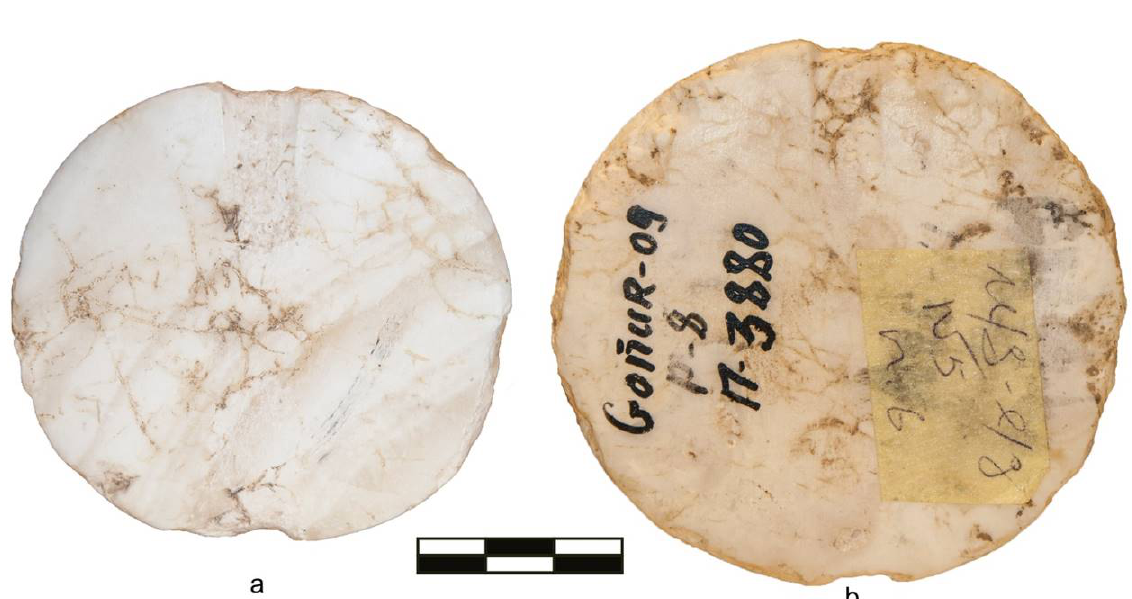
Figure 9. Bases of a miniature column from Gonur Depe: a. top base; b. bottom base. Scale bar is 3 cm long, separated into three 1 cm segments.